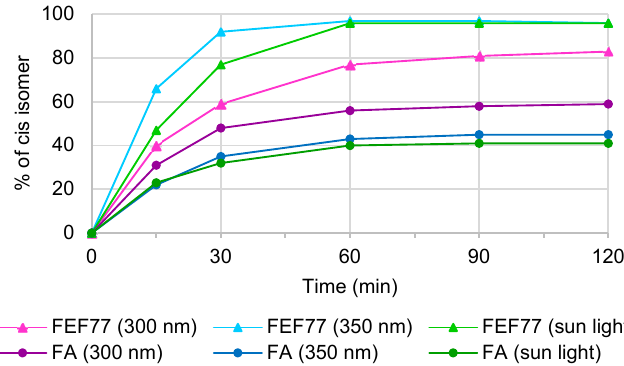
Figure 2. Photoisomerization of FA and FEF77 over time.